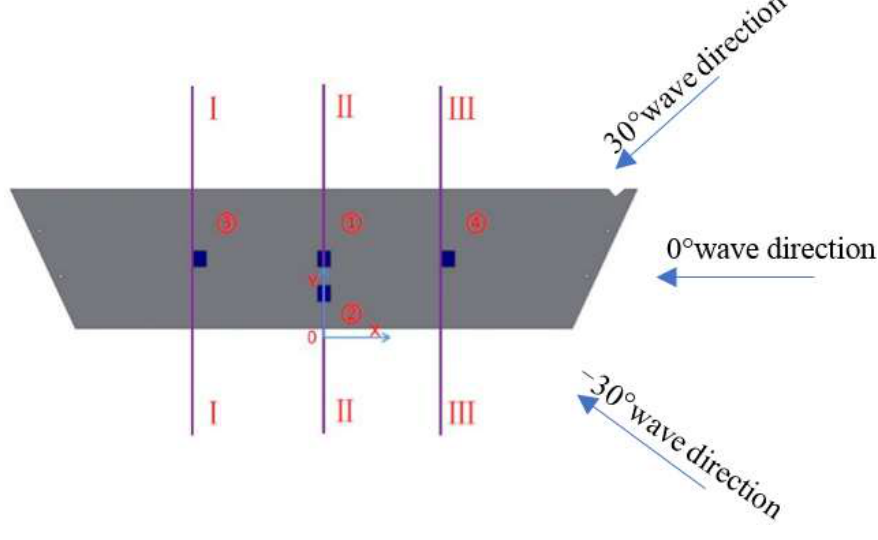
Figure 3. Measuring-points and wave directions.